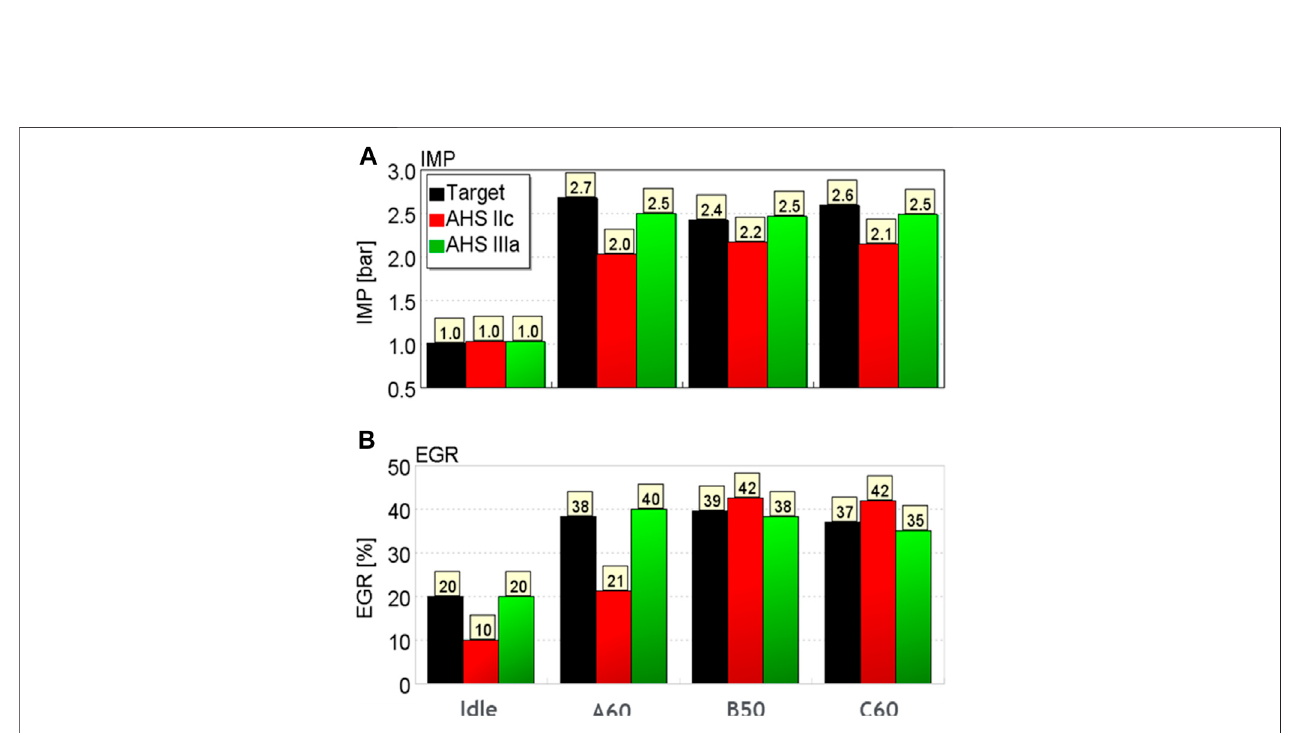
FIGURE 16 | Comparison of AHS IIc and IIIa performances against boost pressure and EGR rate targets.